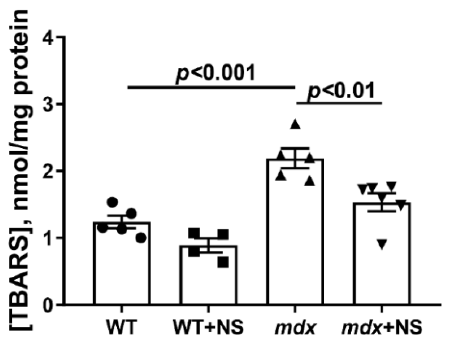
Figure 4. The effect of NS1619 on lipid peroxidation in mitochondria. Lipid peroxidation was as- sessed by the level of TBARS in the skeletal muscle mitochondria of the experimental animals. The data are presented as m ±